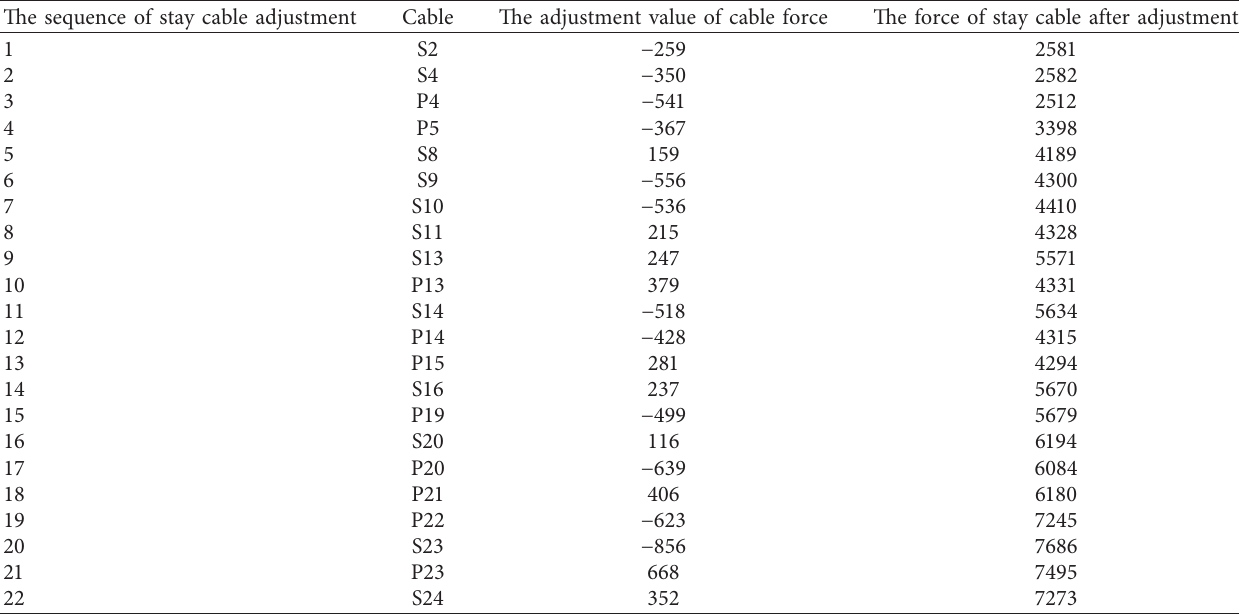
Figure 10: Cable forces before and after adjustments. (a) Cable force error of stay cable. (b) Cable force error of stay cable. Table 5: The adjusted values of cable forces